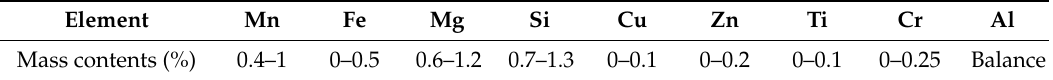
Table 1. Chemical compositions of Al6082-T6 sheets.